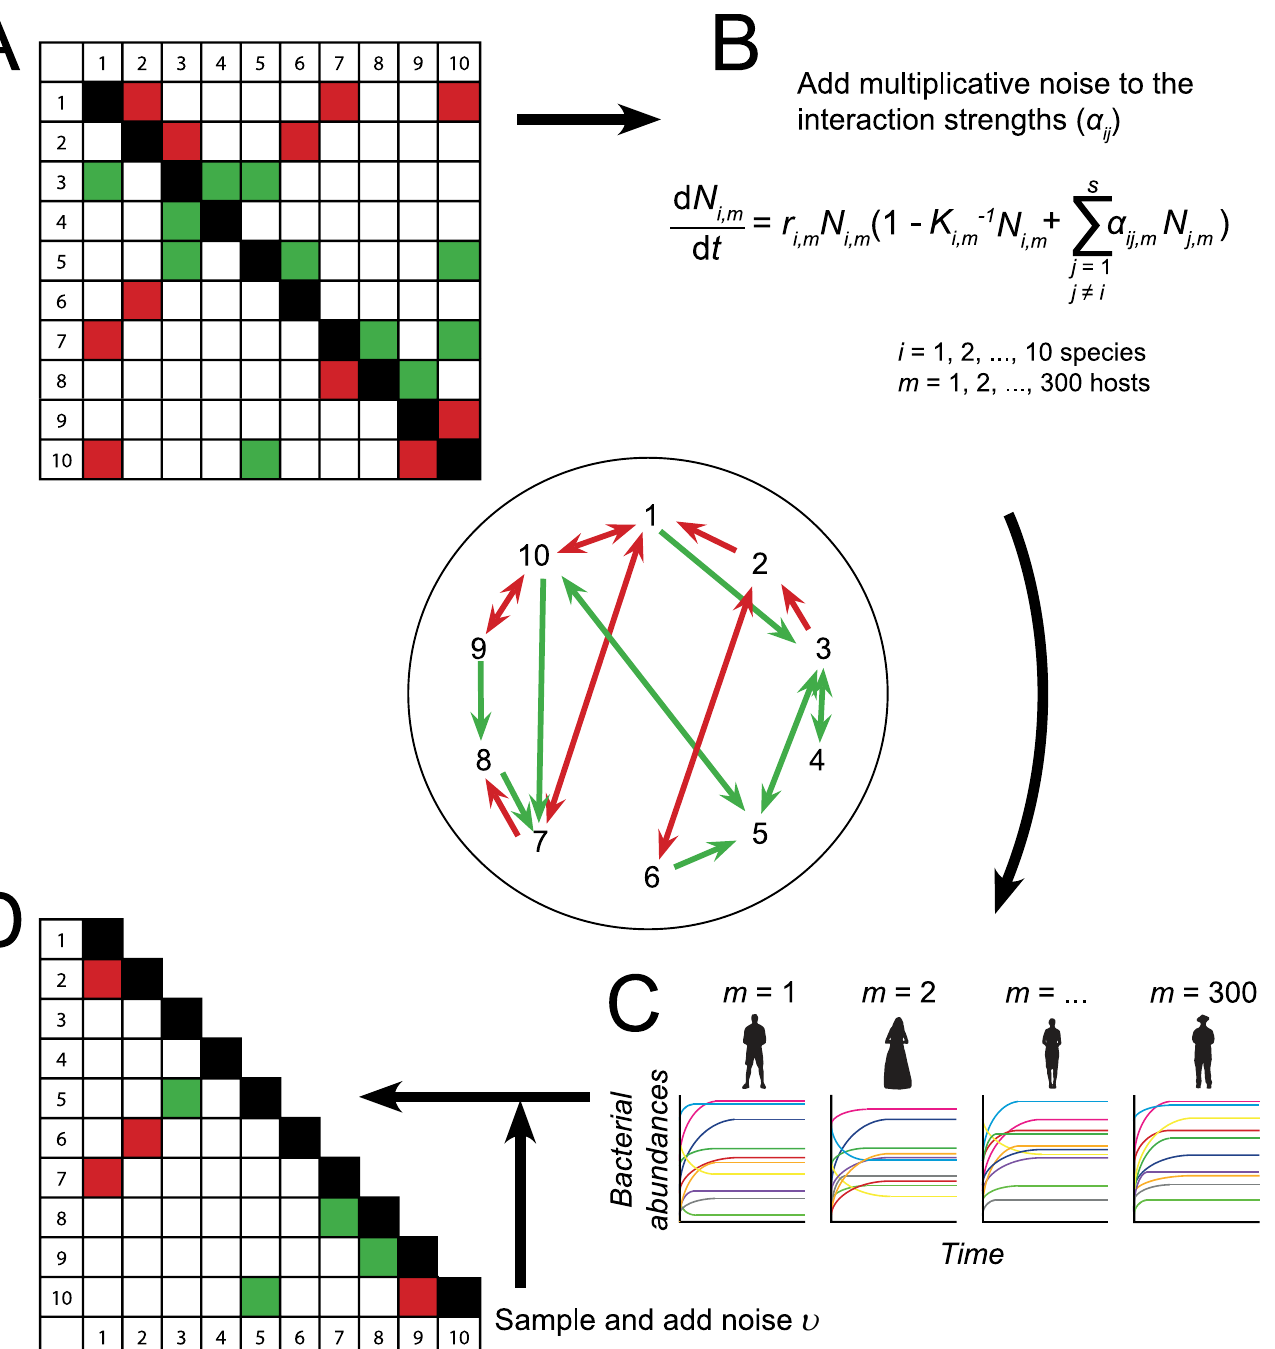
Fig 1. Representation of the workflow. In an interaction network singular green and red arrows represent a commensalistic interaction and an amensalistic interaction respectively, whereas double green arrows represent mutualism and double red arrows competition. A green and red arrow signifies an exploitative interaction. See S1 Fig for more details. (A) A random interaction matrix i . This interaction matrix is implemented in the gLV model (B) together with the intrinsic growth rates and carrying capacities of the species. (C) All timeseries are (slightly) different due to the variation in the interaction strengths. (D) The partial correlations are calculated from the abundances per species sampled from the 300 different hosts at equilibrium. Only the significant correlations and the lower part of the matrix are used for the comparison with the original interaction matrix i . Variations to the workflow were studied by adding for example a perturbation or process